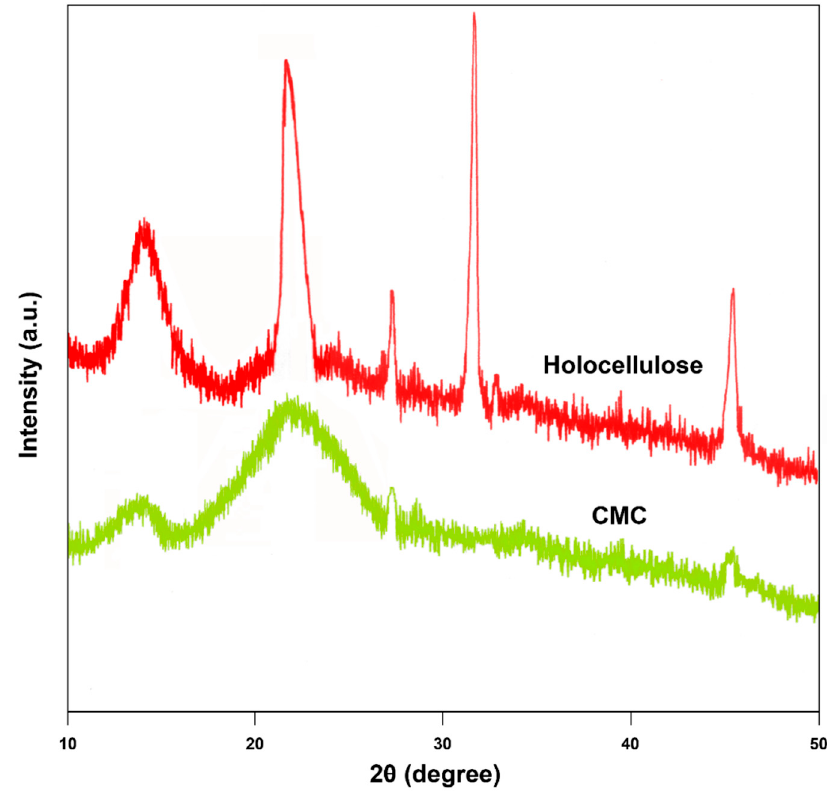
Figure 7. X-ray di ff ractogram of extracted holocellulose and synthesized CMC (with degree of Figure 7. X-ray diffractogram of extracted holocellulose and synthesized CMC (with degree of substitution of substitution of 1.83).